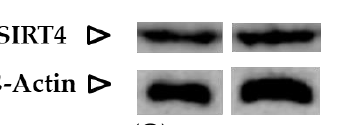
Figure 2. Graphs ( A – C ) represent absolute SIRT 1–3 enzyme activity (Units/µg), ( D – F, M ) represent relative protein expression and ( J – L ) represent relative gene expression of SIRT 1–4. ( G – I , N, O ) are representative images of Western blots. * p < 0.05, ** p < 0.01; ( n = 3–8). Data are represented as mean + SD.